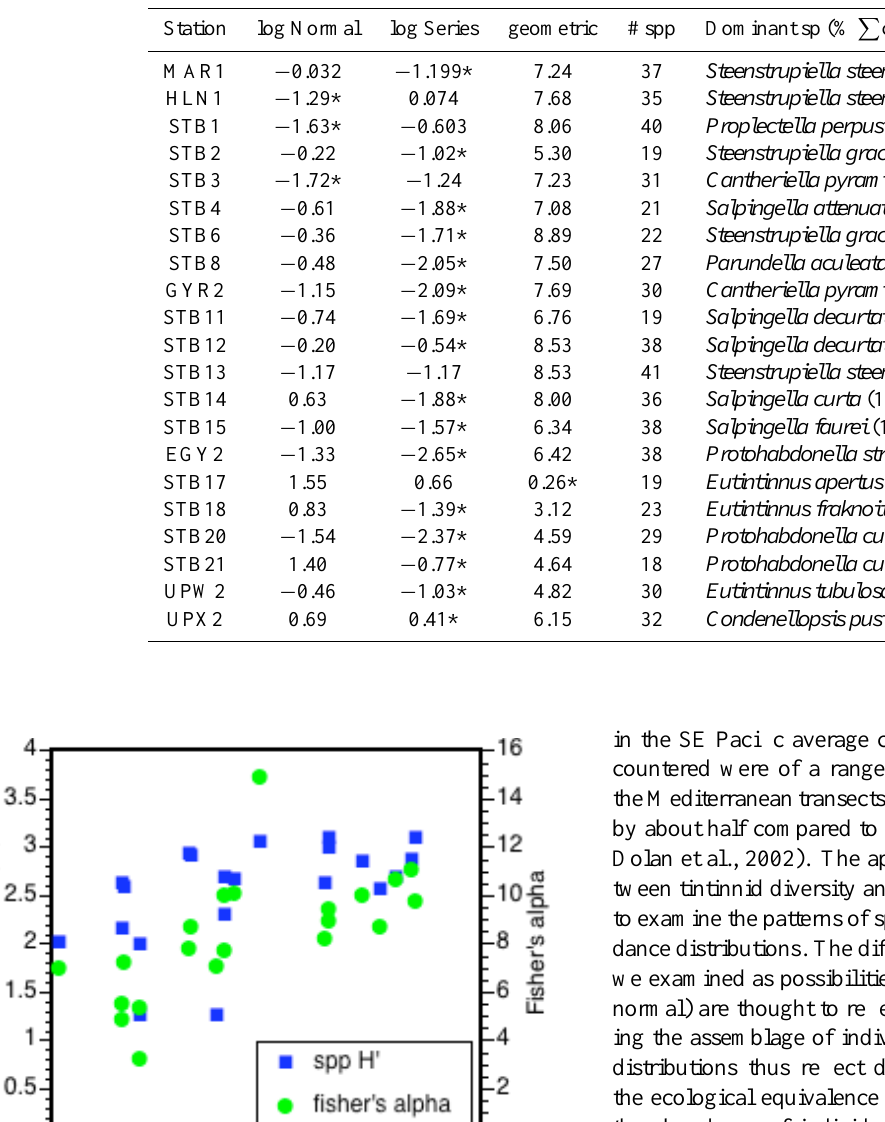
Table 6. Results of analysis of the species abundance distributions. For the tintinnid community of each station, the log-rank abundance curve was compared to model-derived geometric, log normal and log-series curves using the Akaike test. Asterisks denote the lowest AIC value indicating the closest fit.